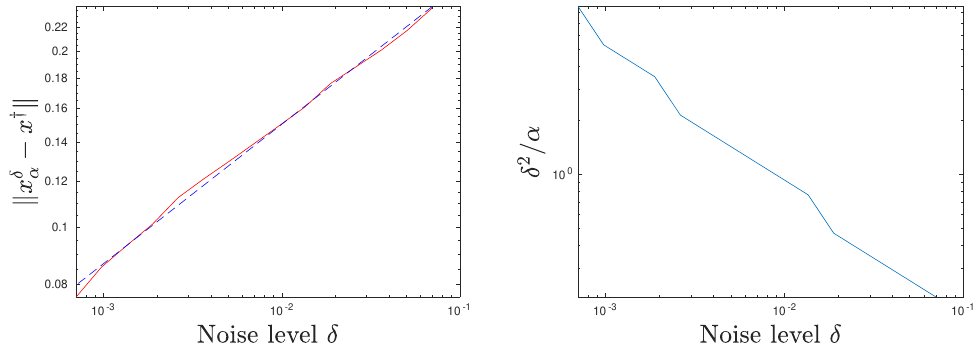
Figure 2. Approximation error (cid:107) x δ α − x † (cid:107) X in red and approximate rate in blue/dashed ( left ) and δ 2 ( right ), both depending on various δ on a log-log